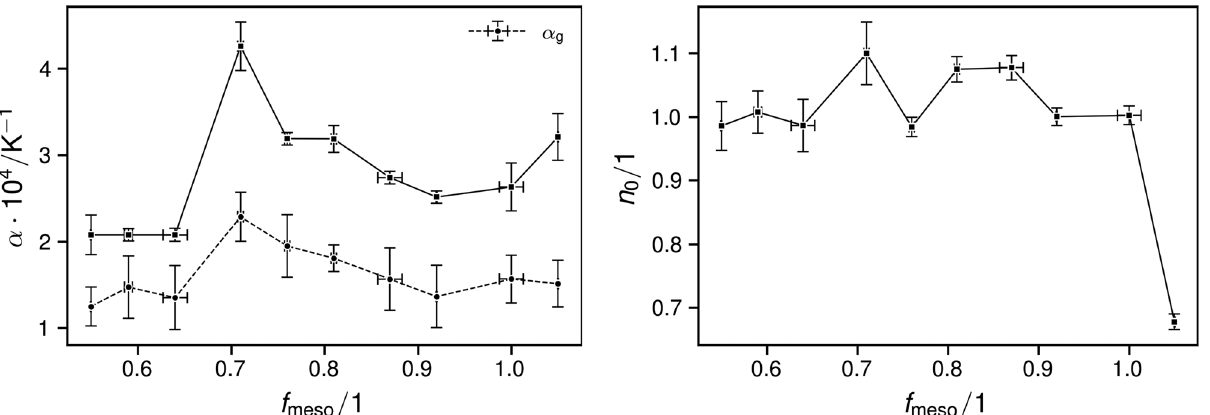
Figure 3: Thermal expansion coe ffi cients in the liquid ( squares and full lines ) and glassy states ( circles and dashed lines ) .